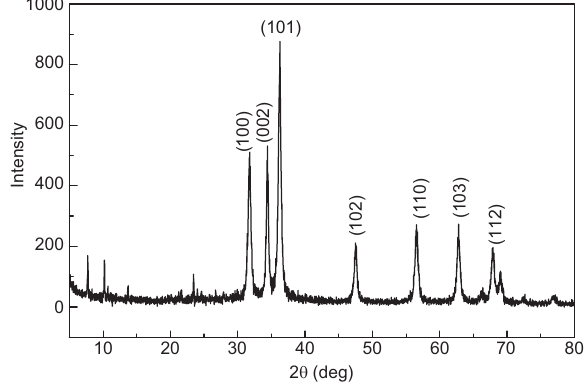
Figure 1 XRD pattern of nano